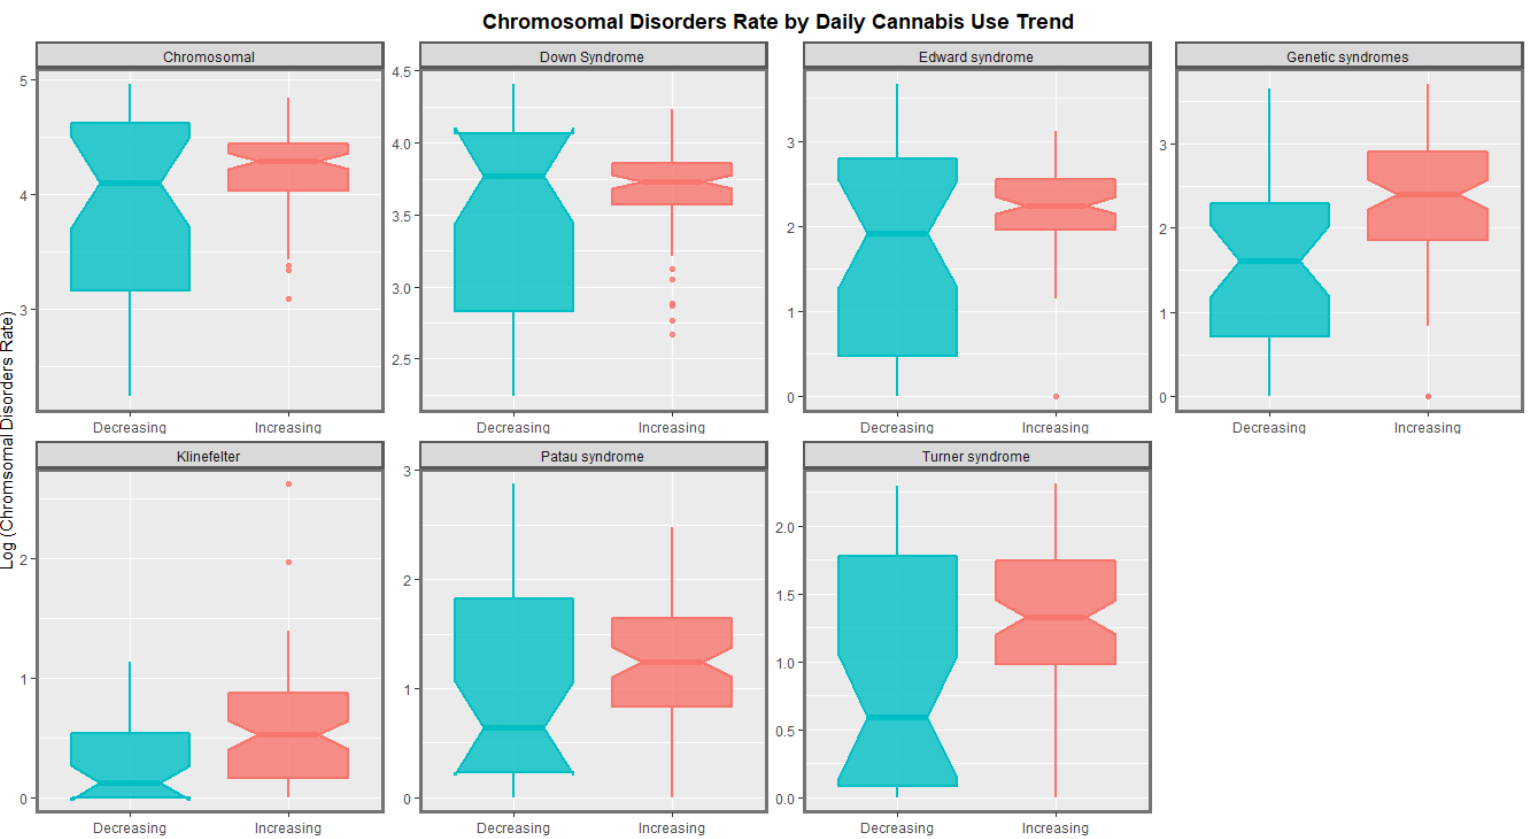
Figure 9. Aggregated log rates of chromosomal disorders over time by category of daily cannabis use by anomaly. Non-overlapping notches on the boxes indicate statistically significant differences.